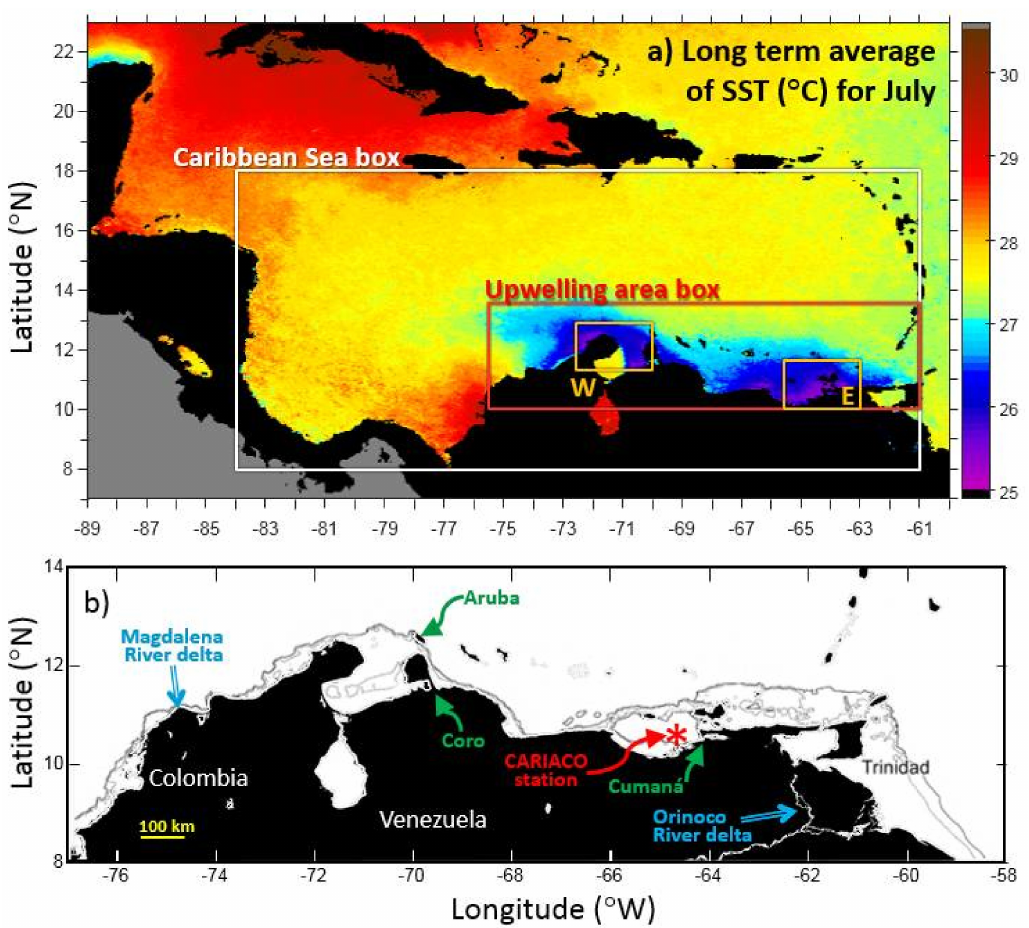
Figure 1. Study area. ( a ) Long-term average (1994–2009) of sea surface temperature (SST) for July, showing the boxes used to calculate spatial averages for the Caribbean Sea (8–18 ◦ N, 61–84 ◦ W, white box), the whole upwelling system (10–13.5 ◦ N, 61–75.5 ◦ W, red box), the west (W) upwelling area (11.3–12.9 ◦ N, 70–72.5 ◦ W), and the east (E) upwelling area (10–11.5 ◦ N, 63–65.5 ◦ W); yellow boxes. The Pacific Ocean is masked in gray. ( b ) Map of the southeastern Caribbean Sea showing the isobaths of 200 and 100 m (dark gray and light gray lines, respectively). The map also shows the location of the CARIACO Ocean Time-Series station (10.50 ◦ N, 64.66 ◦ W), major river deltas, and sites where in situ data were